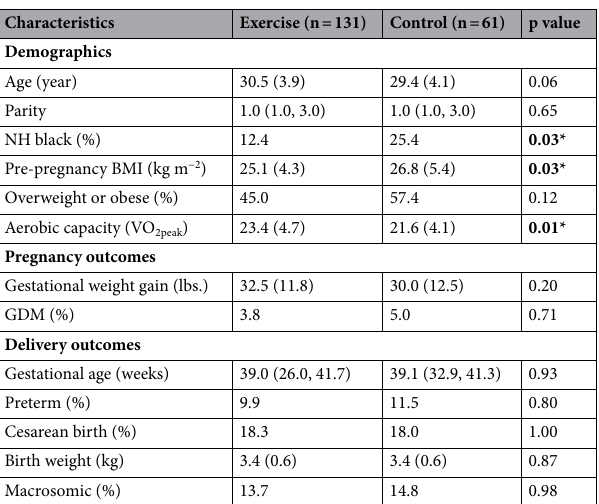
Table 1. Intention to treat analysis of maternal descriptive, pregnancy, and delivery outcomes by Intervention Group. Means (SD), medians (range) and proportions are reported and Student’s t-test, Wilcoxon Rank Sum tests and Fisher’s Exact tests were performed, respectively. NH non-Hispanic, BMI body mass index, GDM gestational diabetes mellitus. *p < 0.05, **p < 0.01, p < 0.001. Significant values are in